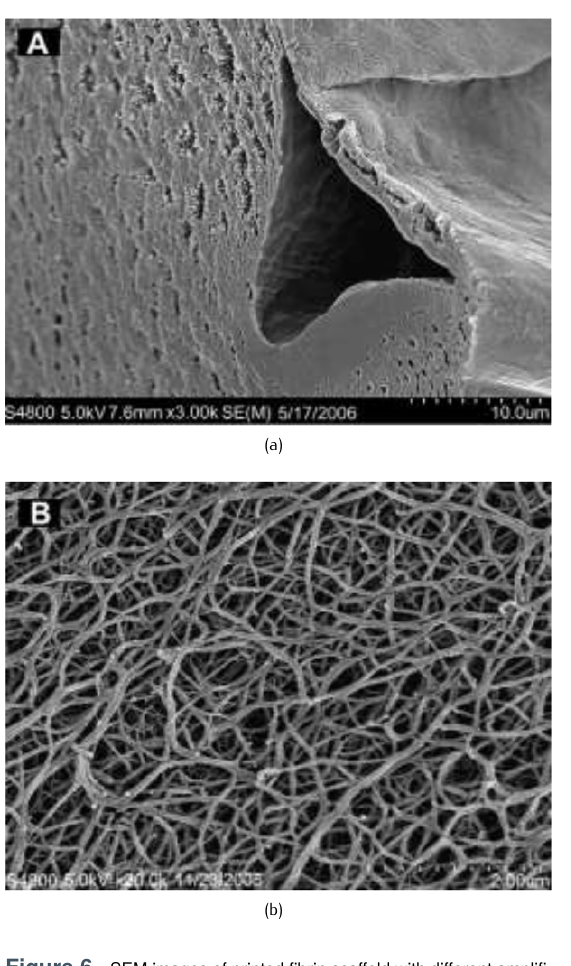
Figure 6. SEM images of printed fibrin scaffold with different amplifi- cation to highlight nano-sized fibrin fibres [31].